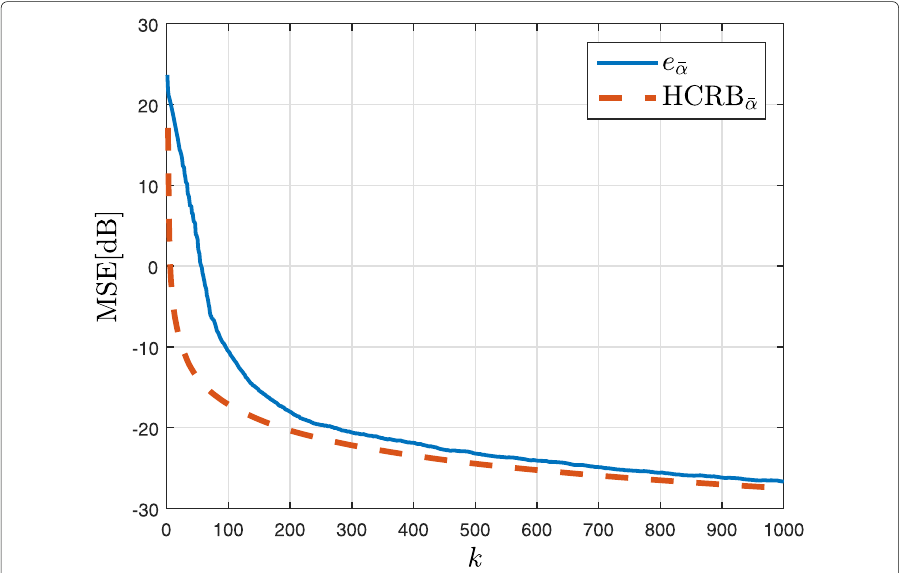
Fig. 3 Mean square error for the estimation of the wall angle α . The solid line depicts e ¯ α , given in (49a) with 500 Monte-Carlo repetitions. The dashed line is the